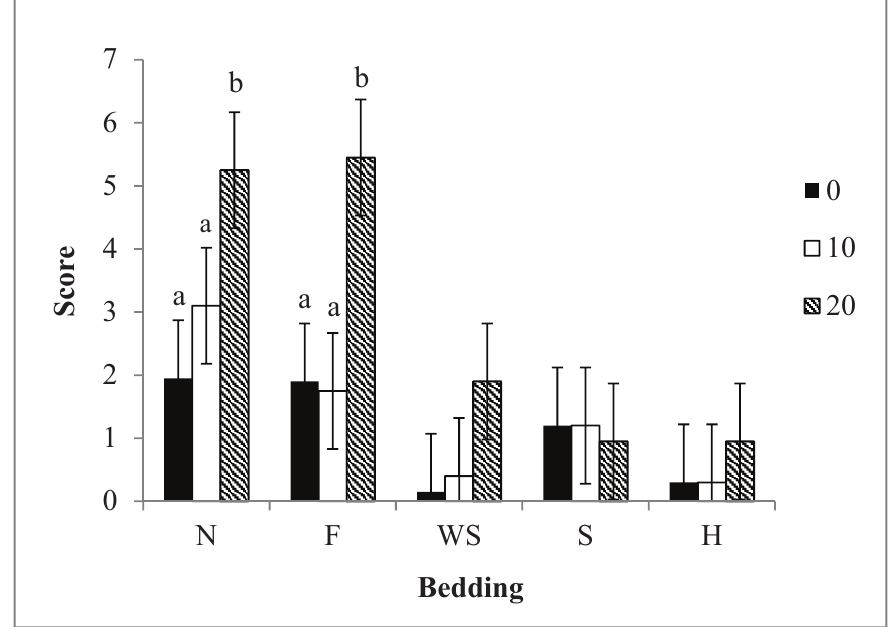
Figure 4. Least Squares means ± 0.92 for weaned pig scores at different ramp slopes with the use of different bedding materials ( P < 0.01). Beddings abbreviated by N = nothing, F = feed, S = sand, WS = wood shavings, H = hay. Bedding was rated on a score system which was calculated by the sum of slips, falls, and vocalizations. n = 12 observations/bedding